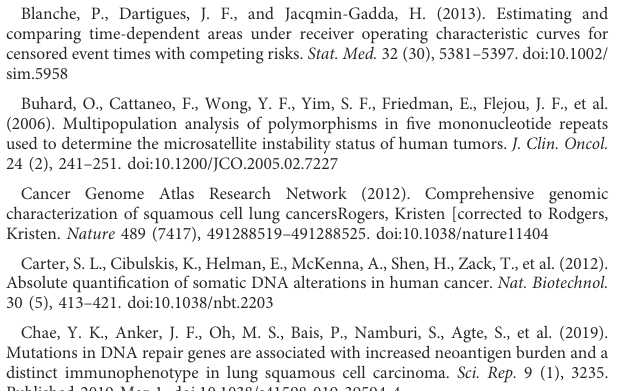
SUPPLEMENTARY FIGURE S1 Genes in the blue, green, brown and red modules. SUPPLEMENTARY FIGURE S2 The process of Least shrinkage and selection operator. SUPPLEMENTARY FIGURE S3 Relationship between MSI-related prognostic risk score (MSI-pRS) and MSi status. SUPPLEMENTARY FIGURE S4 Genomic feature exploration of MSI-related prognostic risk score (MSI-pRS). SUPPLEMENTARY FIGURE S5 Functional enrichment in the GSE73403 external validation cohort. SUPPLEMENTARY FIGURE S6 ImmunefeaturesofMSI-pRShighandMSI-pRSlowgroupintheTCGA-LUSC internal validation cohort and the GSE73403 external validation